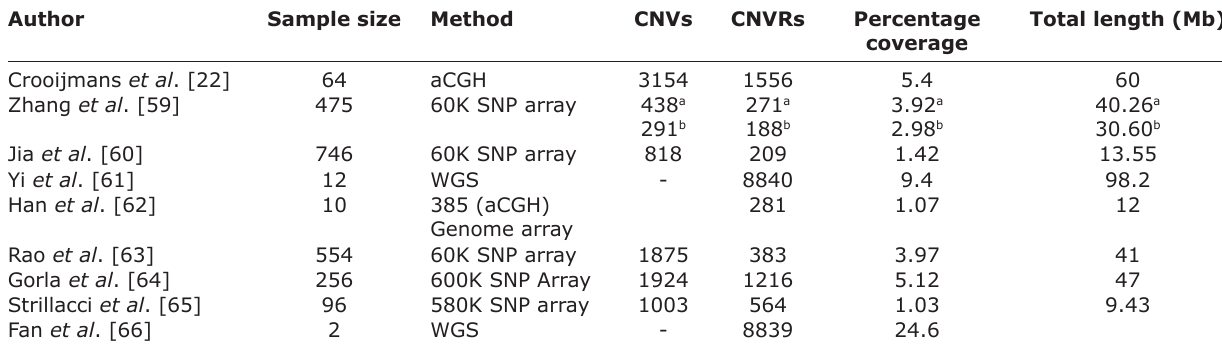
Table-3: CNVs detection studies in chicken using different approaches